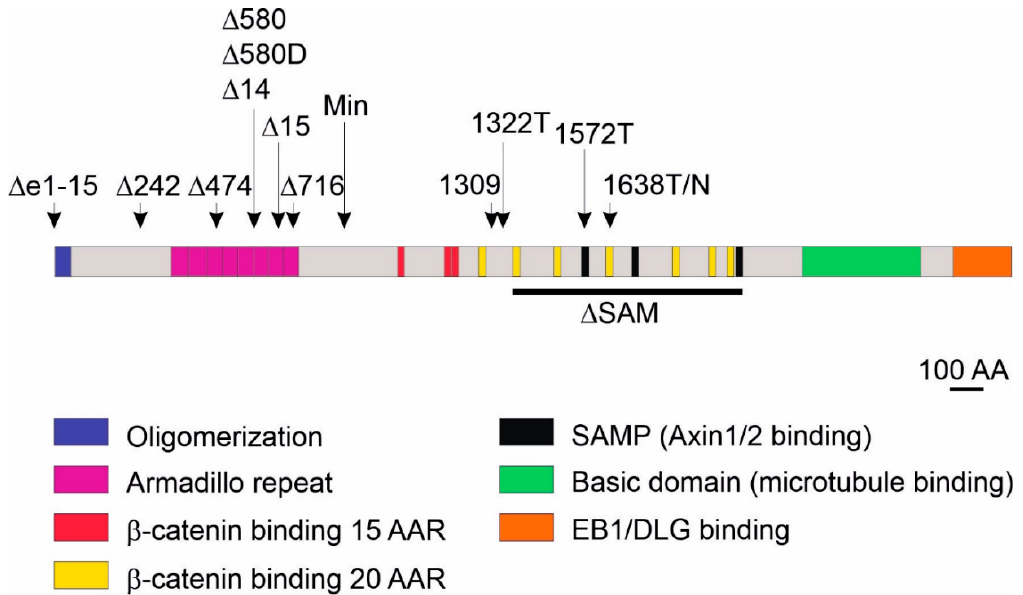
Figure 2. The domain structure and truncated variants of mouse adenomatous polyposis coli (Apc) protein. The scheme indicates positions of germline Apc mutations utilized in mouse models. The names of mutations correspond to the terms used in the studies describing a particular cancer model; the region which was deleted in the Apc Δ SAM allele is underlined; Δ indicates deletion; AA, amino acid; AAR, amino-acid repeats; Axin, Axis inhibition; DLG, discs large; EB1, end-binding protein 1; SAMP, serine–alanine–methionine–proline.